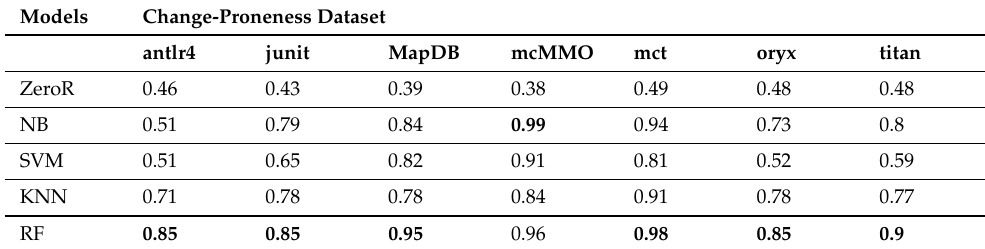
Table 15. Scenarios in the empirical study.